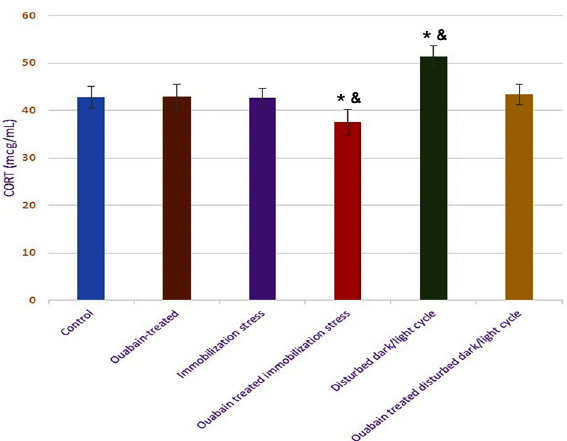
Figure 6. Hippocampal corticosterone (CORT) level (mcg/mL) of study groups. Data are reported as means ± SD. *P o 0.05 compared to the control group; & P o 0.05 compared to ouabain- treated group